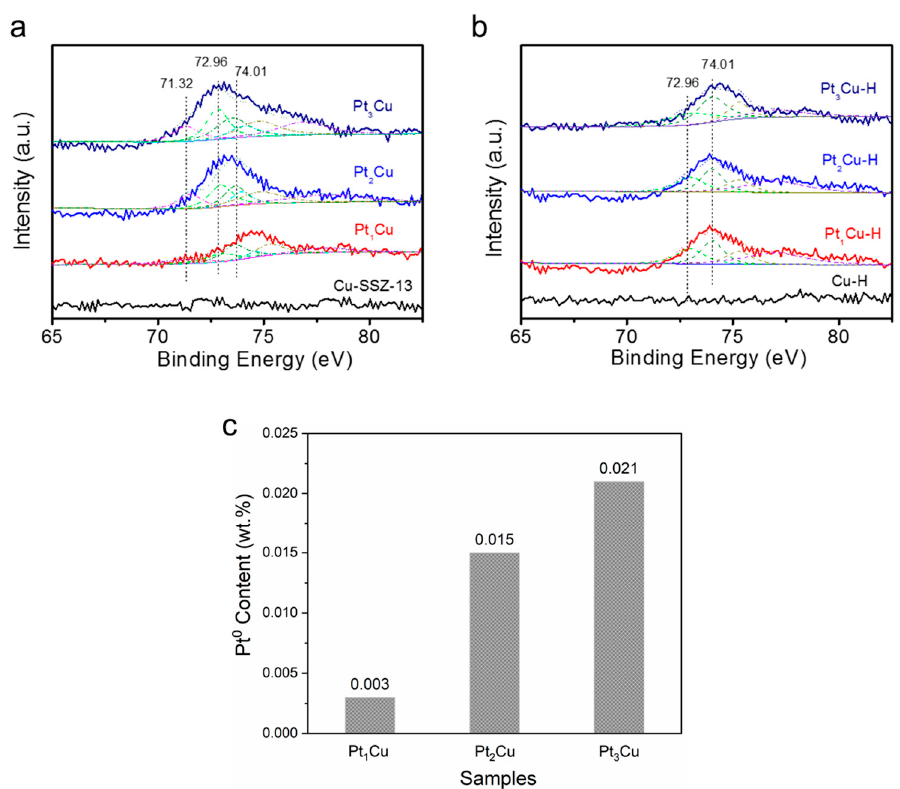
Figure 5. Pt 4f XPS results of the catalyst samples. ( a ) Fresh samples, ( b ) aged samples, ( c ) Pt 0 content in PtxCu samples.